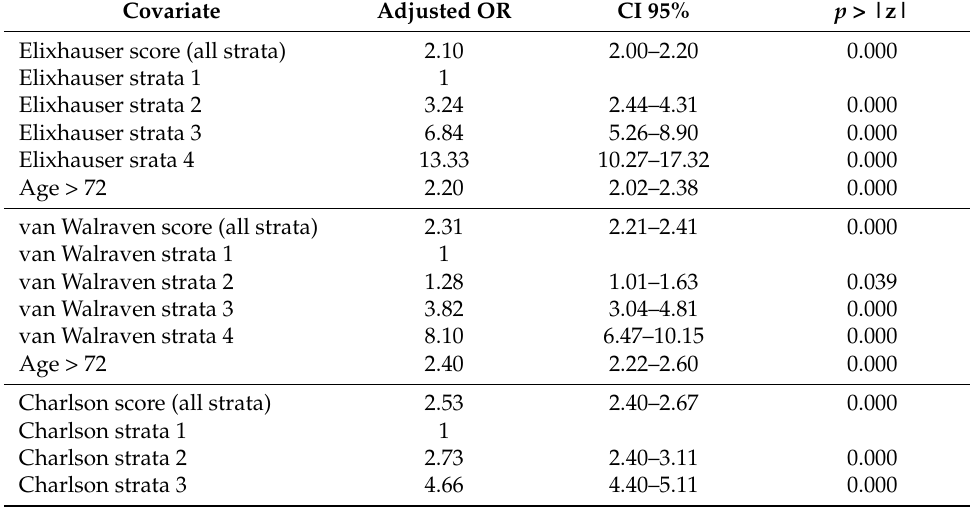
Table 5. Analysis adjusted for mortality by covariates: age and Elixhauser, van Walraven or Charlson